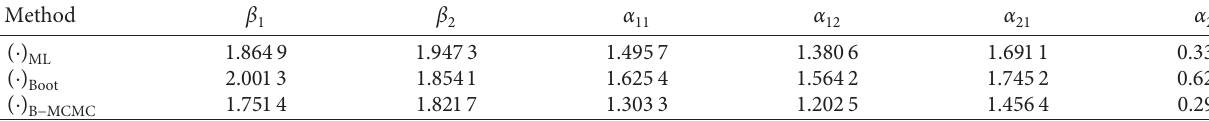
Figure 1: The profile loglikelihood of α Table 3: The point ML, bootstrap, and Bayes estimate.